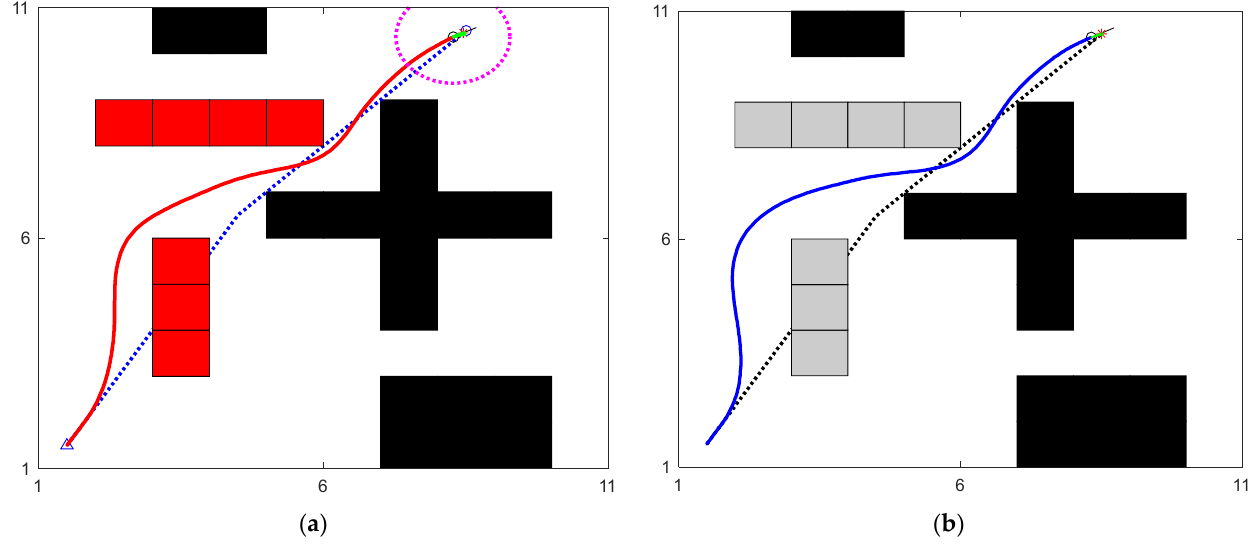
Figure 9. Comparison of robots’ paths. ( a ) Our robot. ( b ) The conventional robot. The global path (blue dotted line and black dotted line), the conventional DWA planning path (red line), the improved DWA planning path (blue line).